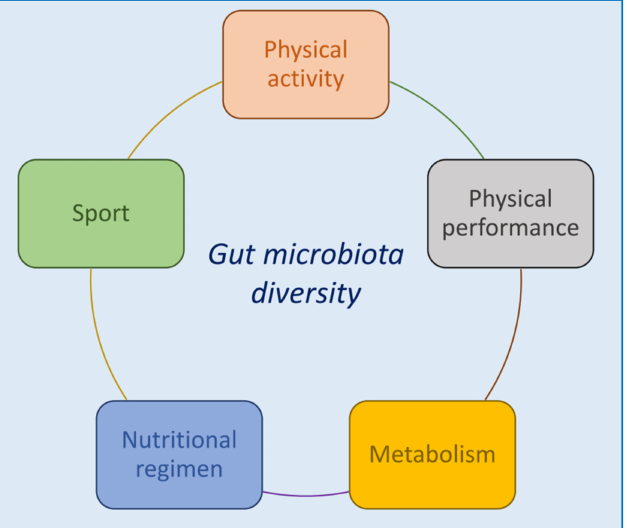
Figure 3. Schematic diagram depicting the factors that contribute to modify the gut microbiota in